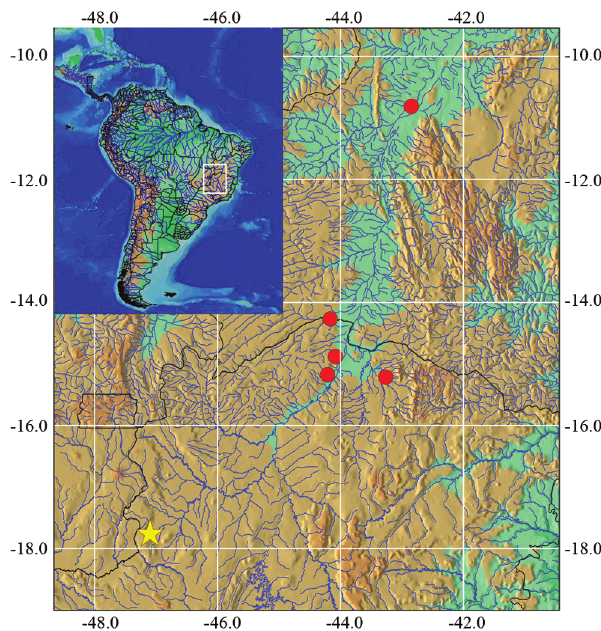
Fig. 5. Map showing geographic distribution of Corydoras lymnades . Yellow star represents type locality, rio Guarda- Mor, Minas Gerais State. Each symbol may represent more than one